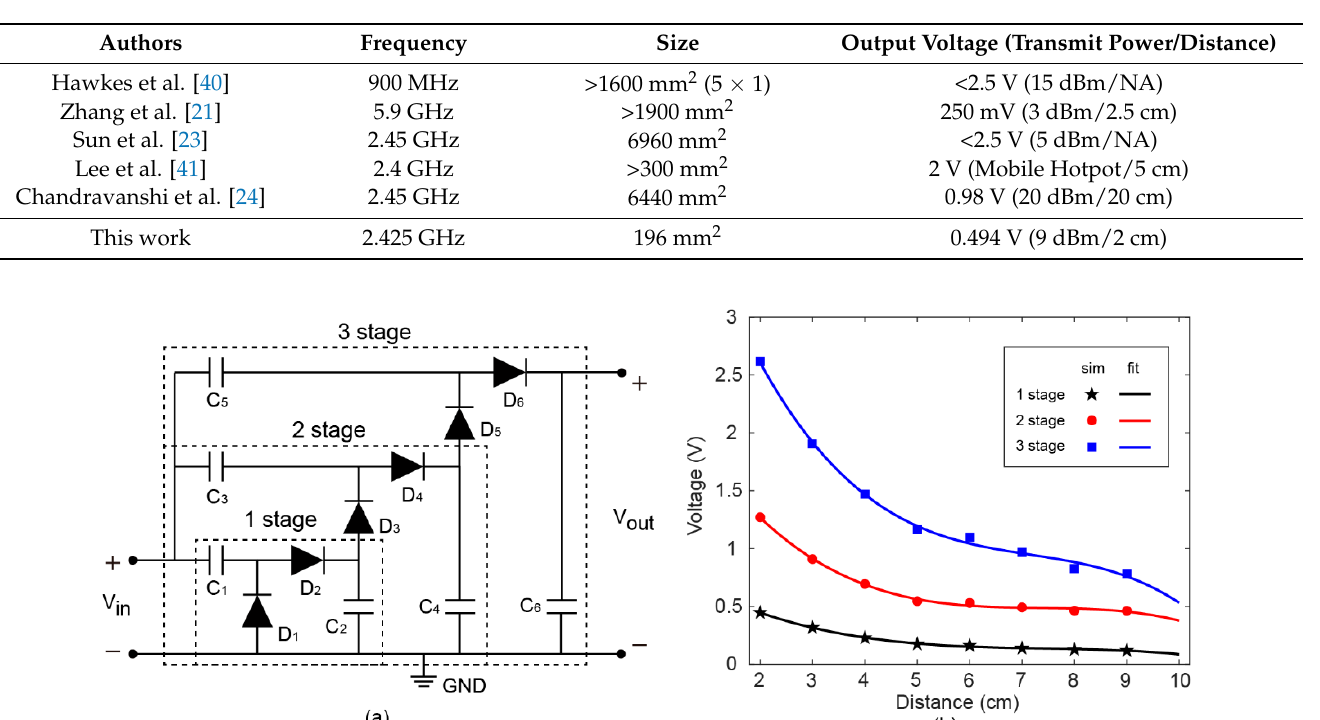
Table 2. Performances for various wireless energy harvester in the RF band.